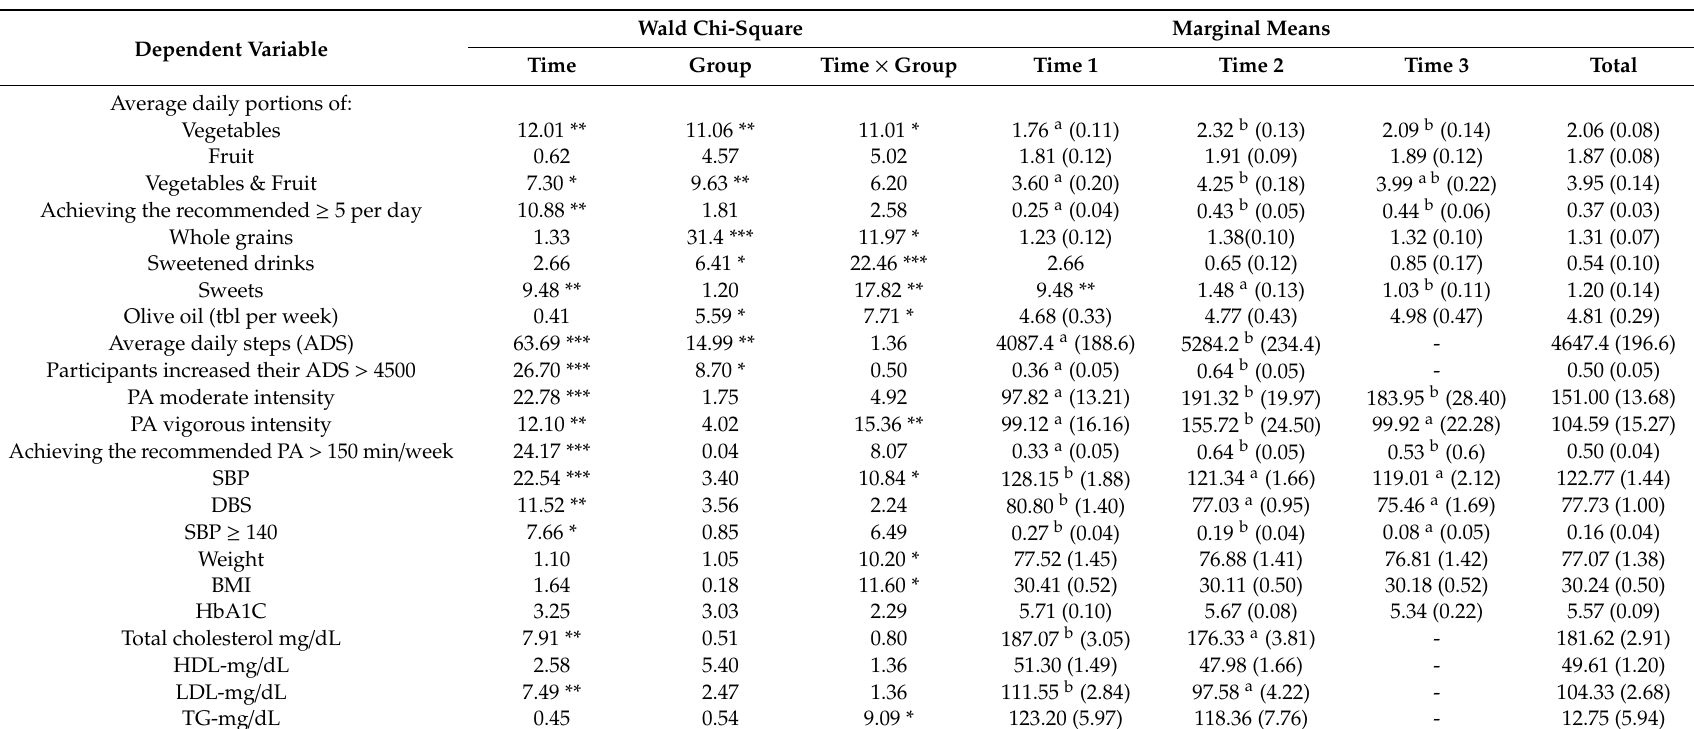
Table 4. GEE regression analysis for di ff erences in outcomes between baselines, six months, and 6 months following the program completion for the dissemination